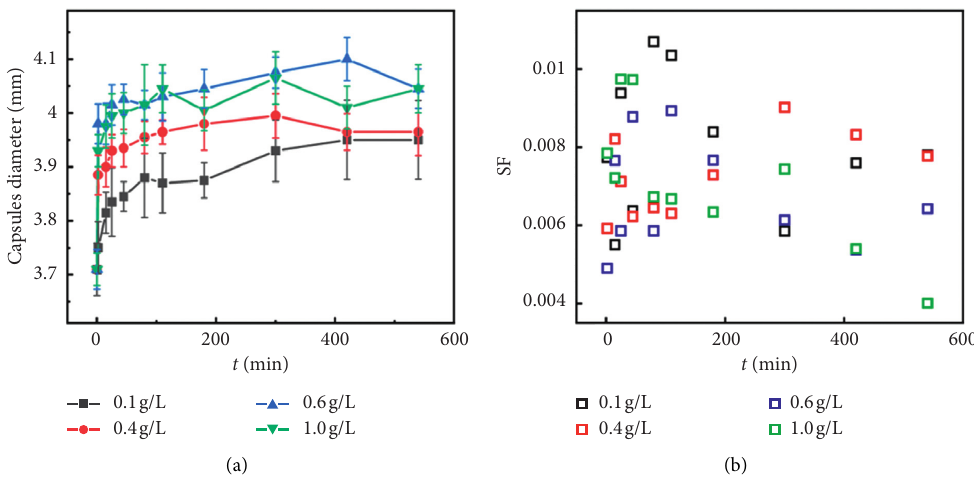
Figure 5: Effect of MWNTs concentration on (a) particle size and (b) SF of capsules during the reaction